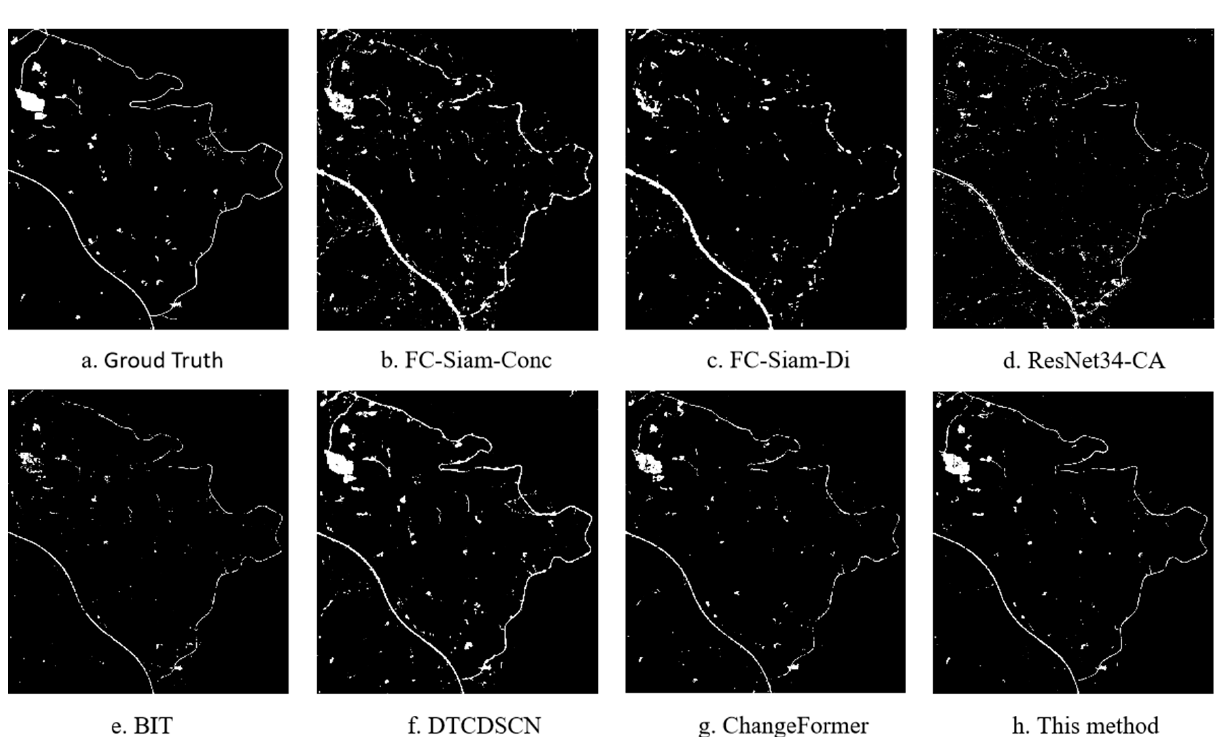
Figure 6. CD results under different methods (sample area).